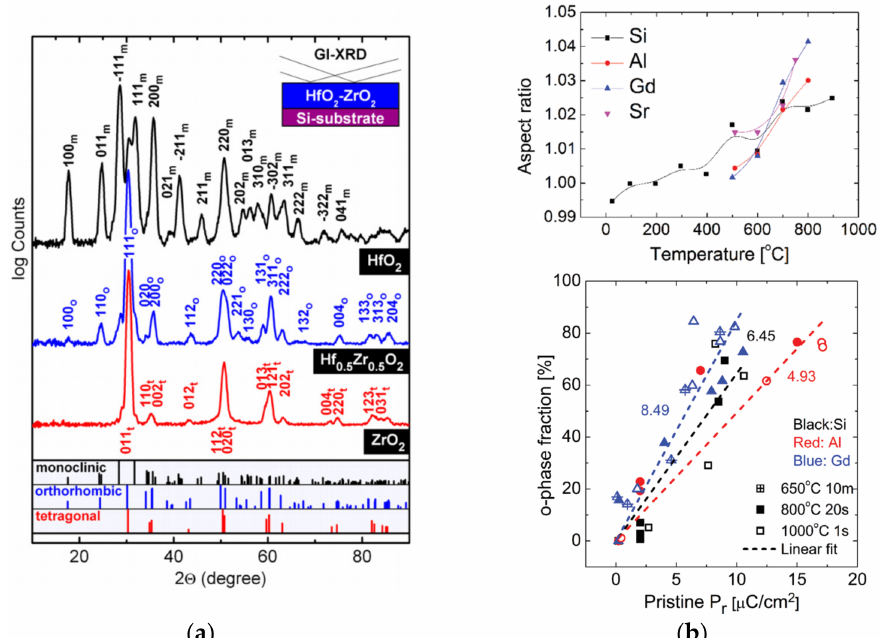
Figure 7. ( a ) GI-XRD measurement depending on the fraction of Hf-Zr. Reproduced with per- mission. [74] Copyright 2012, American Chemical Society. ( b ) Aspect ratio and o-phase frac- tion plot for Si-, Al-, Gd-doped HfO 2 film from XRD data. Reproduced with permission [78]. Copyright 2018, Wiley-VCH.